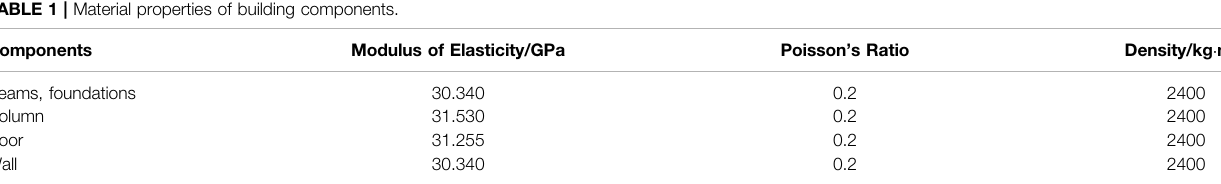
Table 1 . The length of steel fi ber and concrete elements was 4.5